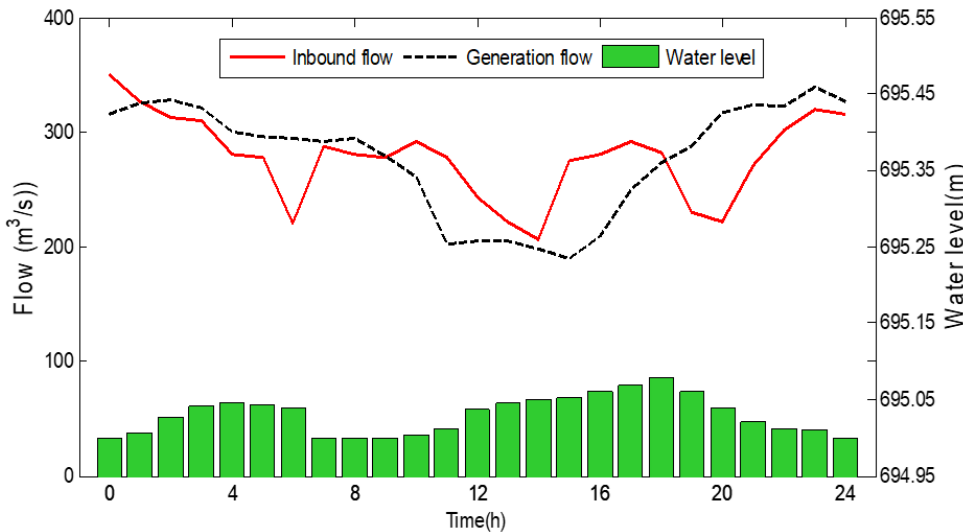
Figure 15. Diagram of reservoir water level and flow change process under the optimization operation